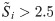
Mesial measures for patient J.ACC, APL and DoL for both the left and the right mesial subnetworks for patient J. The vertical dotted lines mark the times when more than five channels reached S˜i>2.5 (see text for explanation). The x-axis marks the time relative to seizure onset (thick vertical solid line). A moving average over ten consecutive windows is displayed with a thick solid black line.